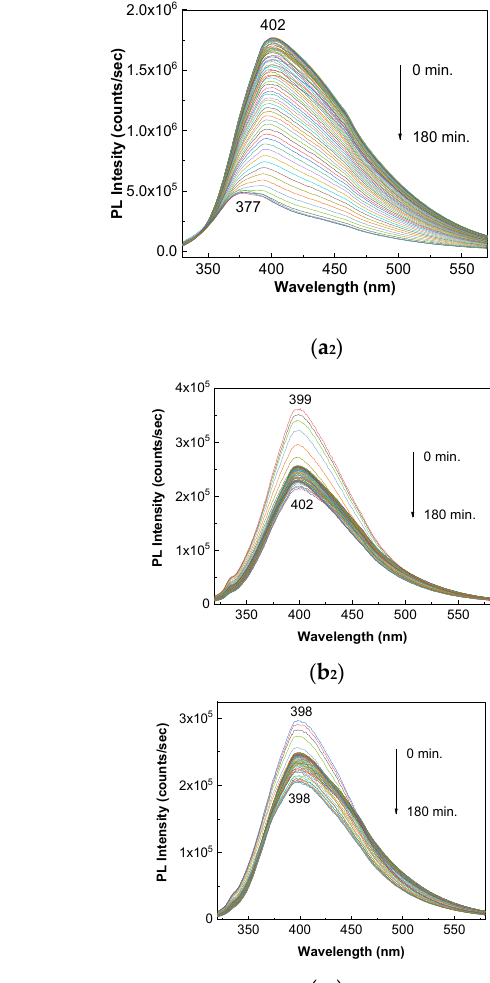
(Figure 8c 2 ), when the volumetric ratio of LO:NaOH is 2:1, 1.5:1.5 and 1:2, respectively; these changes are accompanied by a variation in the PL spectrum maximum at 402 nm (Figure 8a 2 ), 399 nm (Figure 8b 2 ) and 398 nm (Figure 8c 2 ) and (ii) after UV irradiation, to a variation in the PLE and PL spectra intensity, as well as the PLE spectra profile. Thus, when the volumetric ratio of LO:NaOH is equal to: (a) 1:2, a decrease of the PLE spectrum and (b) 1258–1259 cm − 1 and 1454–1458 cm − 1 , from 1.9 and 1.14 (Figure 9, black curve) to 0.47 and 0.44 (Figure 9, red curve), 0.57 and 0.58 (Figure 9, blue curve), as well as 0.95 intensity from 1.84 × 10 6 counts/sec to 1.27 × 10 6 counts/sec occurs (Figure 8c 1 ); (b) 2:1 and and 0.92 (Figure 9, magenta curve); and (iii) a decrease of the ratio between the IR bands 1.5:1.5, a variation in the PLE spectra intensity takes place from 2.36 × 10 6 counts/sec (Fig ‐ absorbance, localized at 1423–1427 cm − 1 and 1454–1458 cm − 1 , associated to the vibrational ure 8a 1 ) and 2.17 × 10 6 counts/sec (Figure 8b 1 ) to 1.53 × 10 6 counts/sec (Figure 8a 1 ) and 1.71 modes: (i) C-N stretching in the tetrazole ring and C-H wagging at the imidazole ring and × 10 6 counts/sec, respectively (Figure 8b 1 ); and (c) 2:1, 1.5:1.5 and 1:2, the PL spectrum C-H scissor between the benzoic and the imidazole rings and (ii) C-O-H bending and C-H intensity varies from 1.76 × 10 6 counts/sec (Figure 8a 2 ), 3.6 × 10 5 counts/sec (Figure 8b 2 ) and scissor in the alkyl chain, respectively, from 0.83 (Figure 9, red curve) to 0.77 (Figure 9, blue 2.96 × 10 5 counts/sec (Figure 8c 2 ) to 4.81 × 10 5 counts/sec (Figure 8a 2 ), 2.14 × 10 5 counts/sec curve) and 0.76 (Figure 9, magenta curve), values which are smaller than that reported for (Figure 8b 2 ) and 2.06 × 10 5 counts/sec (Figure 8c 2 ). LP ( 1 ) (0.86 in Figure 9, black